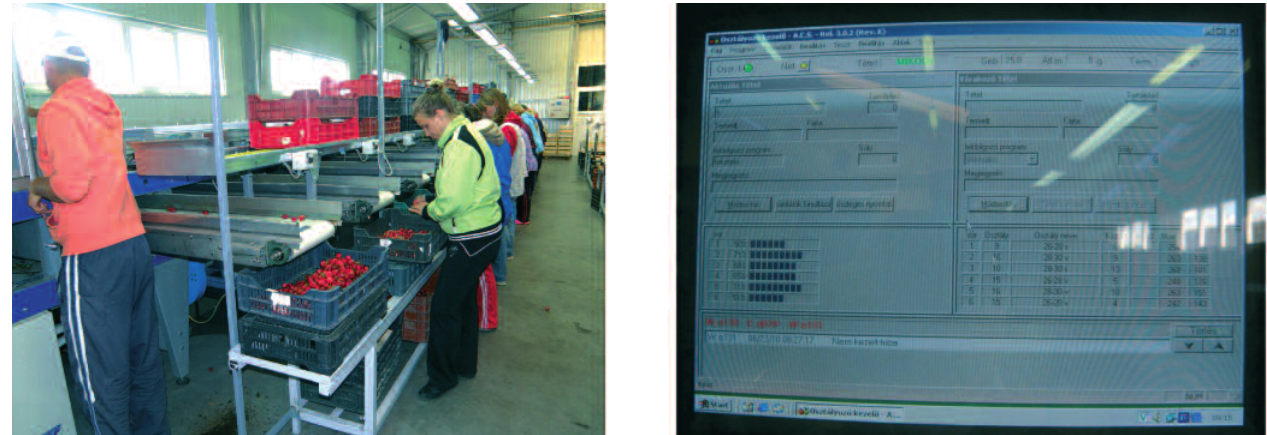
Fig. 9: The sorted product Fig. 10: The graphical user interface (GUI)